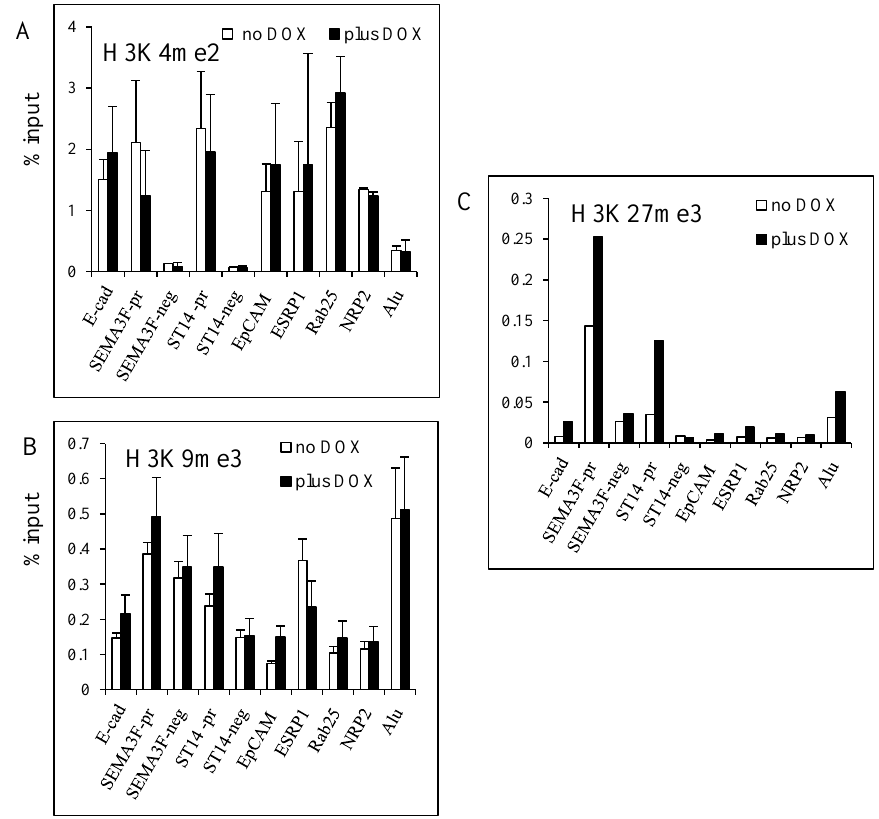
Figure 7. Histone H3K4, H3K9 and H3K27 methylation upon ZEB1 induction. ChIP assays were performed with the rabbit anti-H3K4me2 ( A ), anti-H3K9me3 ( B ) and anti-H3K27me3 ( C ) antibodies on H358 FlipIn ZEB1 cells grown for 48 h in the absence (white bars) or in the presence (black bars) of DOX. Results are expressed as % of input. ( A , B ) Values are from three independent experiments with PCR in duplicate. Bars, SD. ( C ) values are the average of two